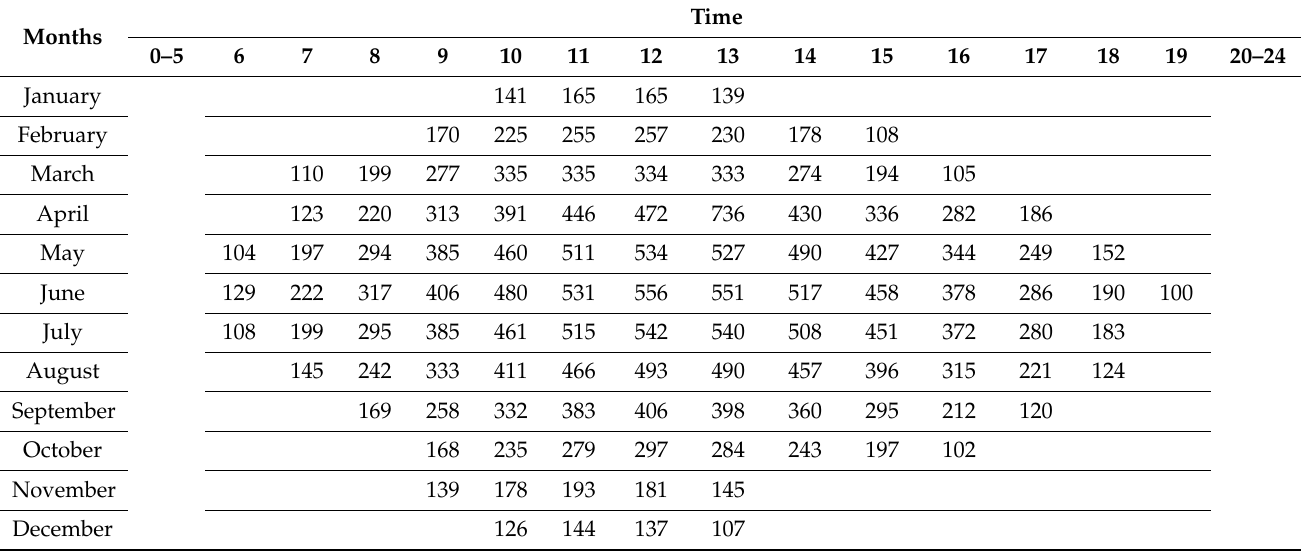
Table 6. Average daily insolation level of the horizontal surface (A), W/m 2 /h *.